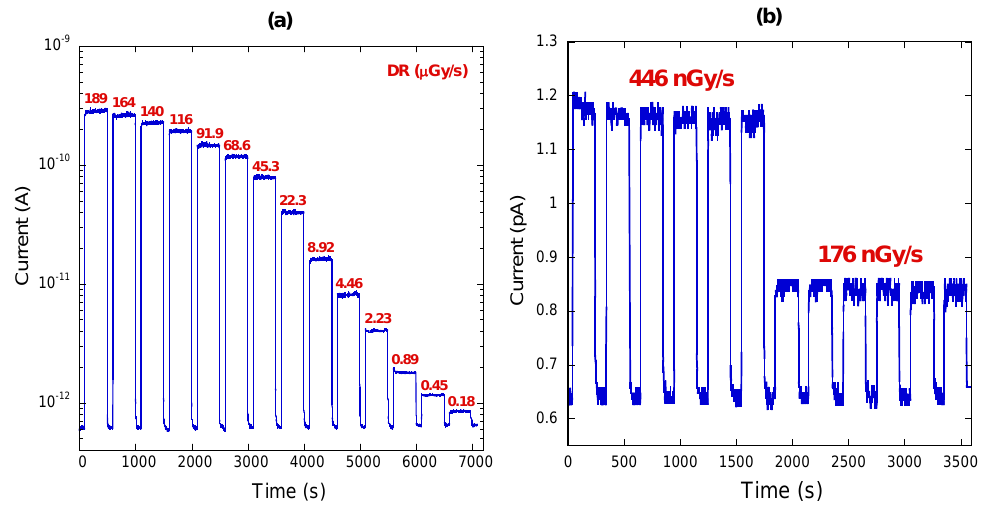
Figure 2. ( a ) Current measured under low-energy X-rays as a function of time. “X-ray on” and “X-ray off” periods were set to 300 s and 100 s, respectively. Red numbers refer to dose-rate values. Current values are reported on a log scale to better highlight the signals at very low dose-rates (<1 µGy/s); ( b ) Current measured under the two lowest investigated dose-rates: six subsequent “X-ray on” and “X-ray off” periods (200 s and 100 s, respectively) were acquired for each